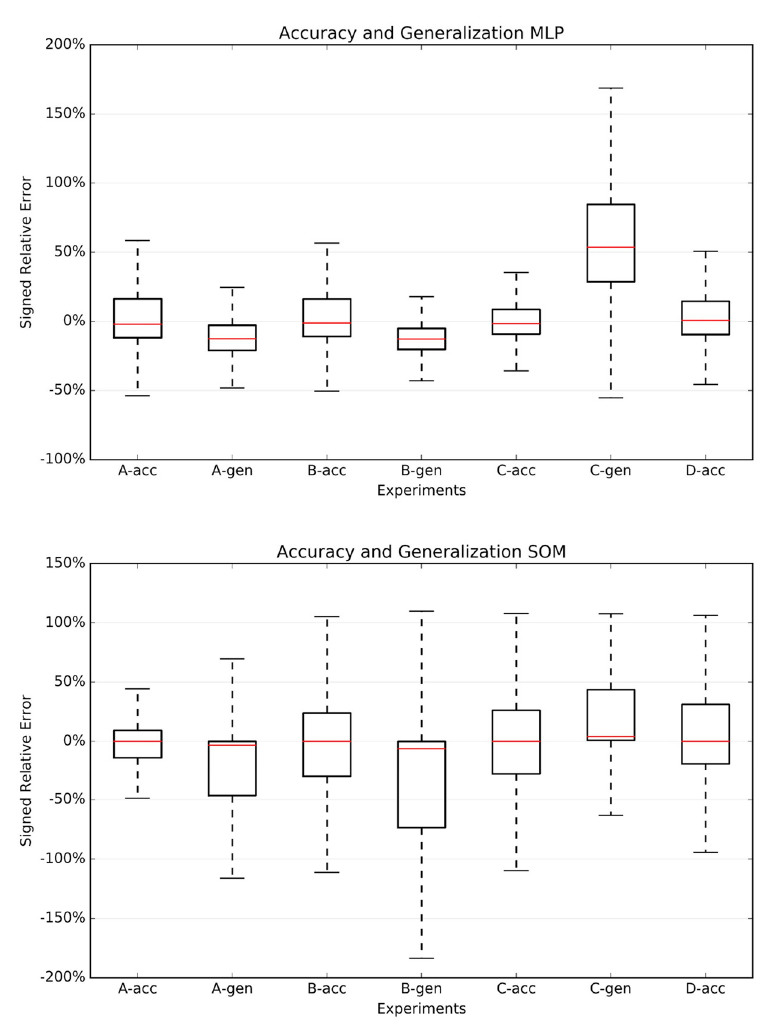
Figure 10. Accuracy (acc) and generalization (gen) of MLP and self-organizing map (SOM) models.